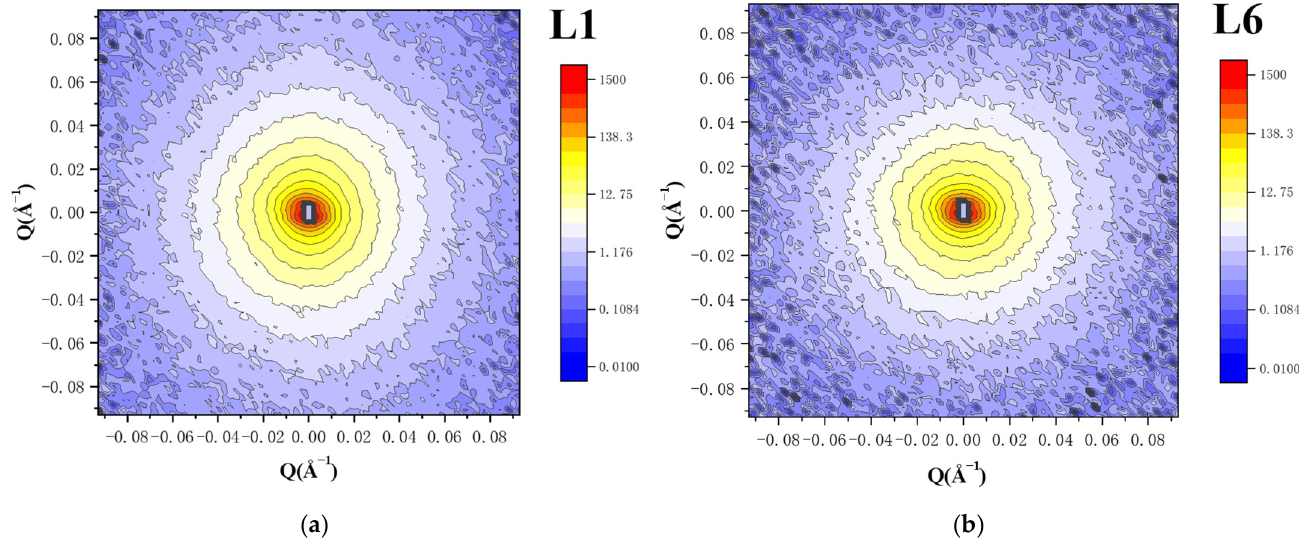
Figure 2. Two ‐ dimensional small ‐ angle neutron scattering intensity spectrum: ( a ) deep shale sam ‐ Figure 2. Two-dimensional small-angle neutron scattering intensity spectrum: ( a ) deep shale samples ples L1 and ( b ) deep shale samples L2. L1 and ( b ) deep shale samples